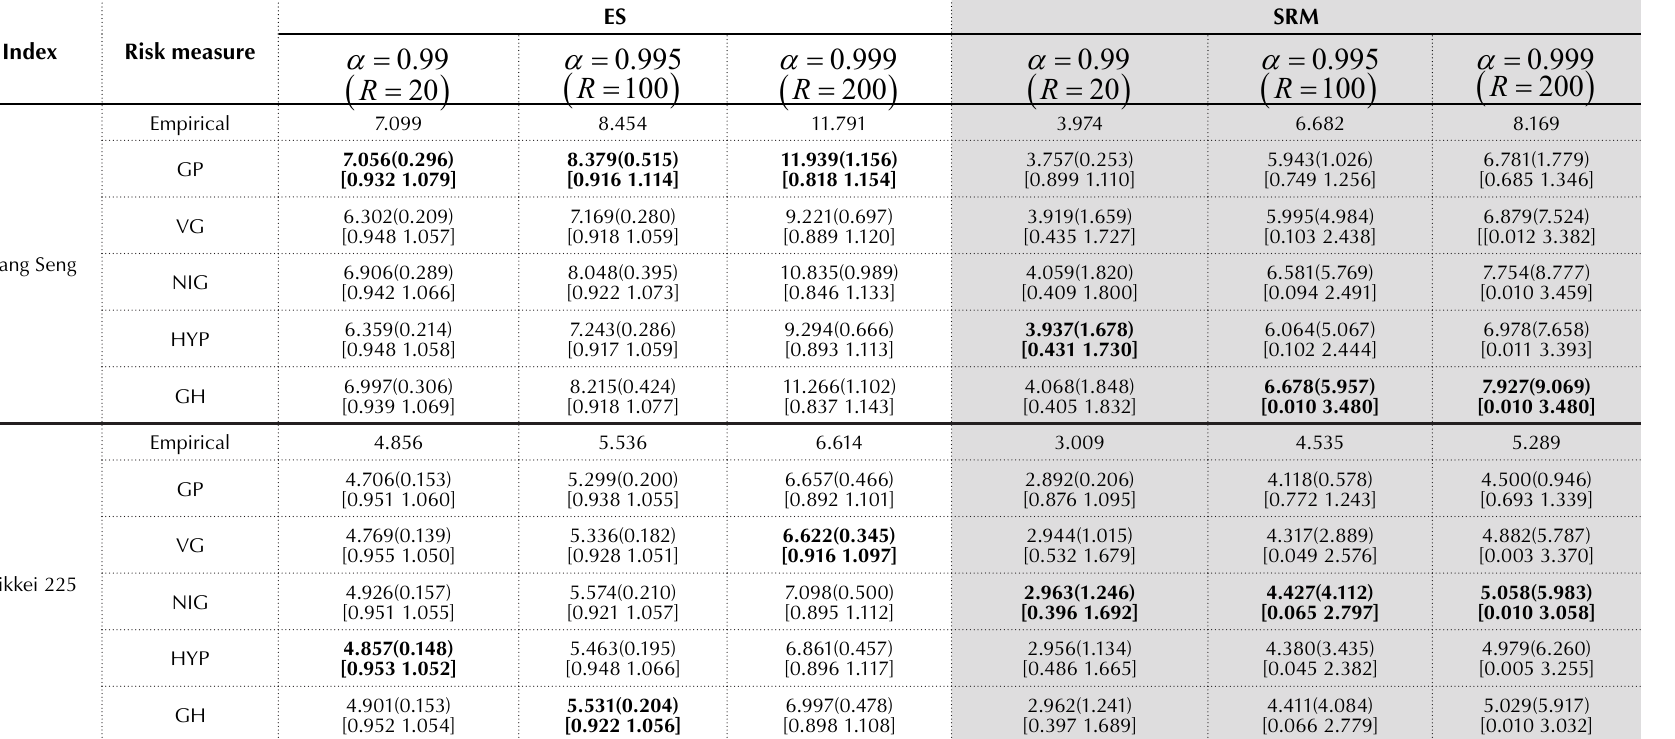
Table 4 (cont.). Estimates of ES and Lévy spectral risk measures for futures position Index Risk measure